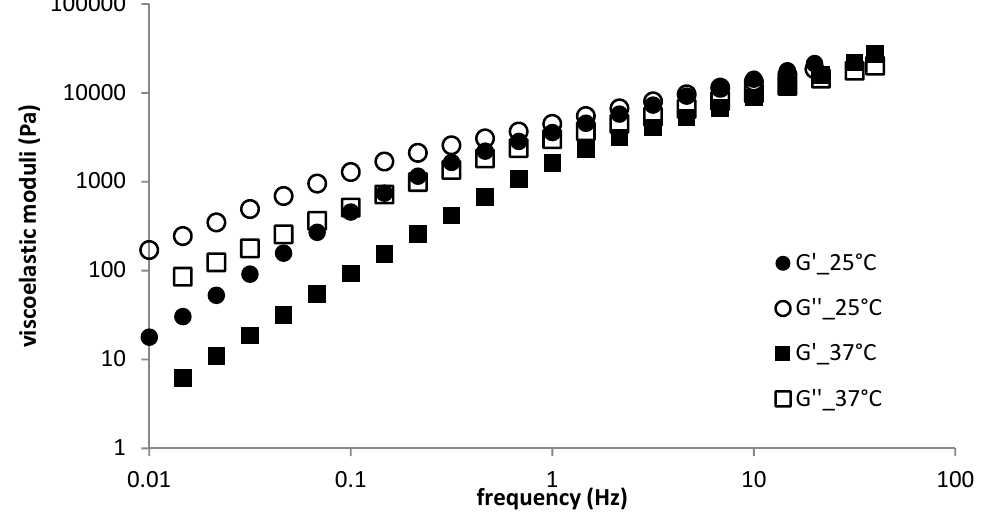
Figure 4. Frequency sweep for sample D2—temperature dependence.